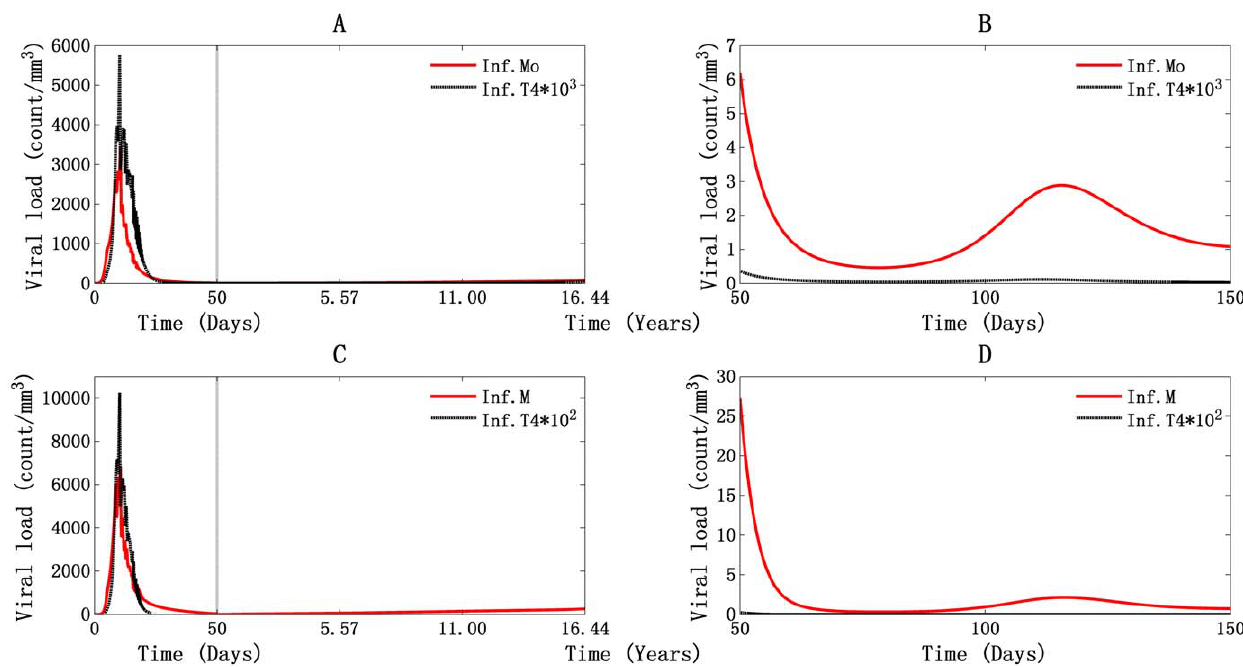
Figure 7. Illustration of viral production by infected monocytes/macrophages and actively infected T4 cells. Panels A and B stand for PB, and panels C and D stand for LNs. The second viral peak lasted from day 50 to day 150 (B and D).